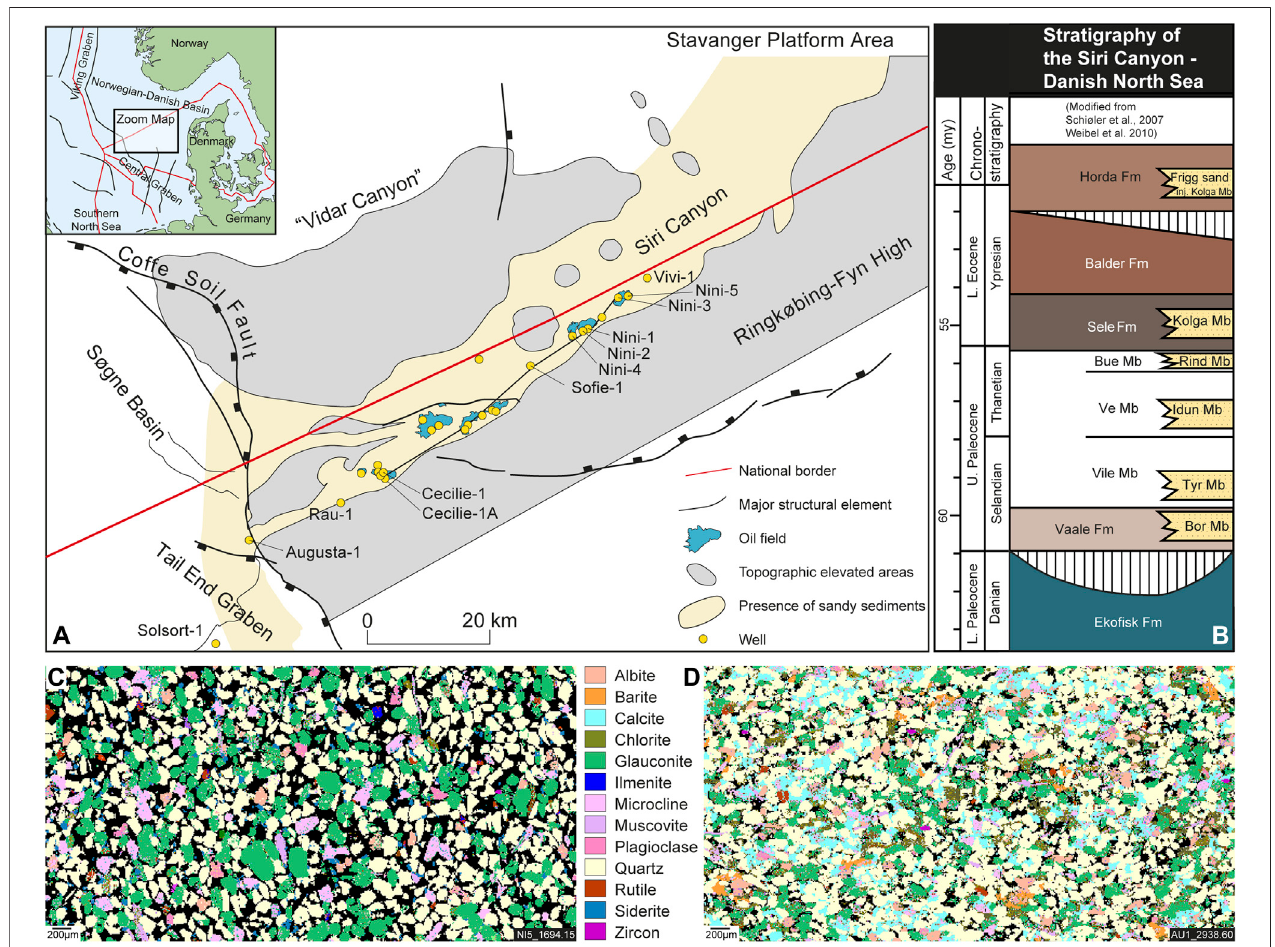
FIGURE1|(A) Map showingwells and oil fi eldsinthe SiriCanyon area, modi fi ed after Friis et al.(2007).Wellsindicatedbyname has beenapplied inthestudy. (B) Stratigraphy of the Siri Canyon. (C) AQM mineral map of the shallowest sample. (D) AQM mineral map of one of the deepest buried sample.